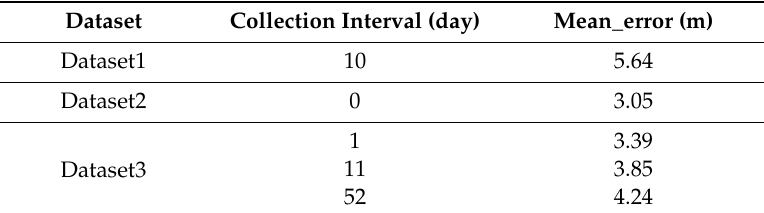
Figure 20. The CDF positioning error of our proposed algorithm on three datasets. ( a ) Dataset1. ( b ) Dataset2. ( c ) Dataset3. Table 3. Average positioning error of the algorithm proposed in this paper on three datasets.